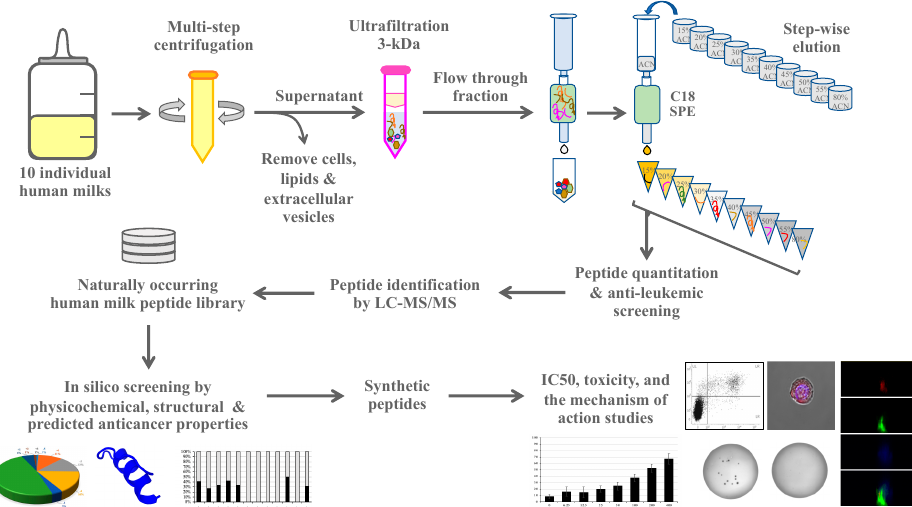
Figure 1. A conceptual framework of the integrative strategy for discovering a novel human-milk-derived antileukemic peptide. This strategy combines the strengths of mass spectrometry for high-throughput peptide identification, in silico screening for prioritizing peptide candidates, and experimental validation for antileukemic activities. Abbreviations: LC-MS/MS, liquid chromatography-tandem mass spectrometry; IC 50 , half-maximal inhibitory concentration; SPE, solid-phase extraction.